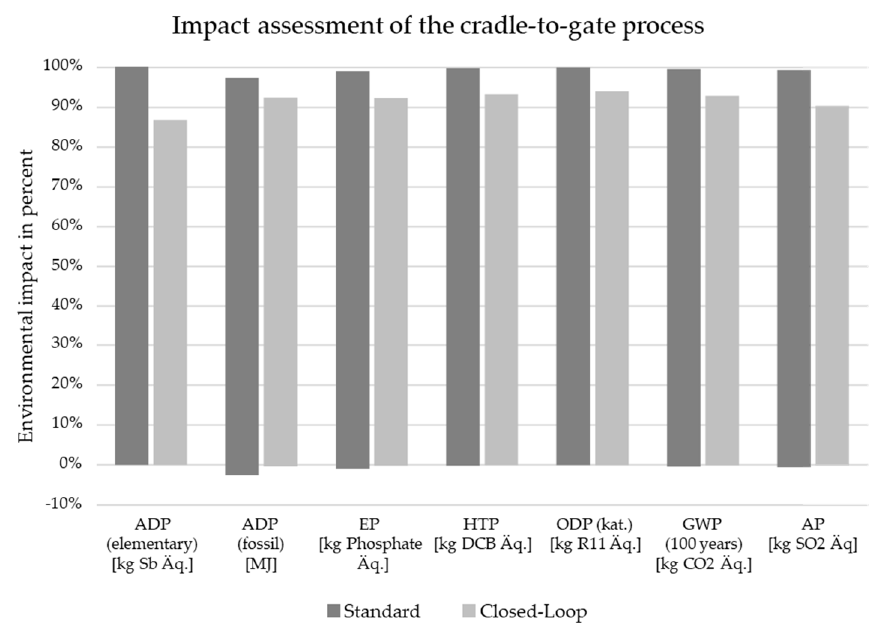
Figure 12. Environmental impacts, comparing life cycle assessment of the cradle-to-gate system boundary of the standard disposal process to the closed-loop recycling process investigated within the scope of this study. In total, 1000 manufactured pieces served as the functional unit.